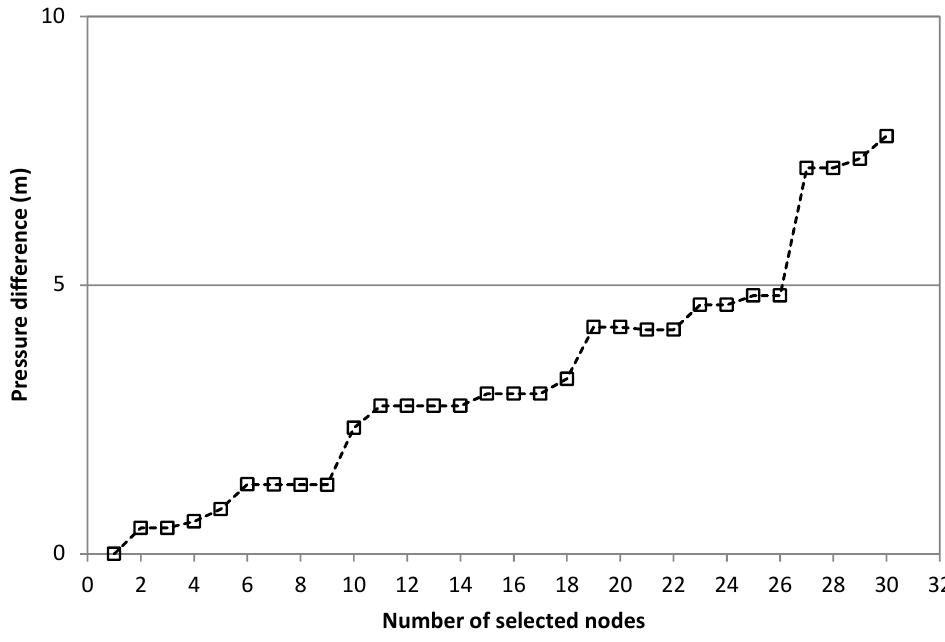
Figure 7. Variation of the pressure difference as a function of the selected nodes.